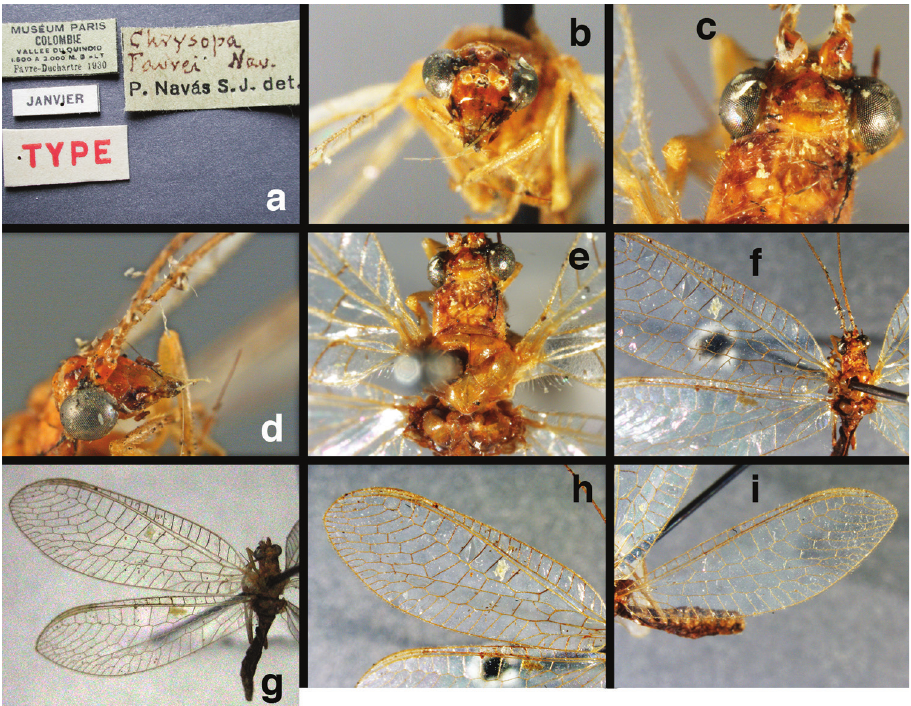
Figure 35. Chrysopa favrei Navás: External features, ( a ) labels ( b ) head, frontal ( c ) head, prothorax, dor- sal ( d ) head, frontolateral ( e ) head, thorax, dorsal ( f ) body, dorsolateral ( g ) body, left wings ( h ) forewing ( i ) hindwing (all: Colombia, Valle de Quindio, lectotype, female,